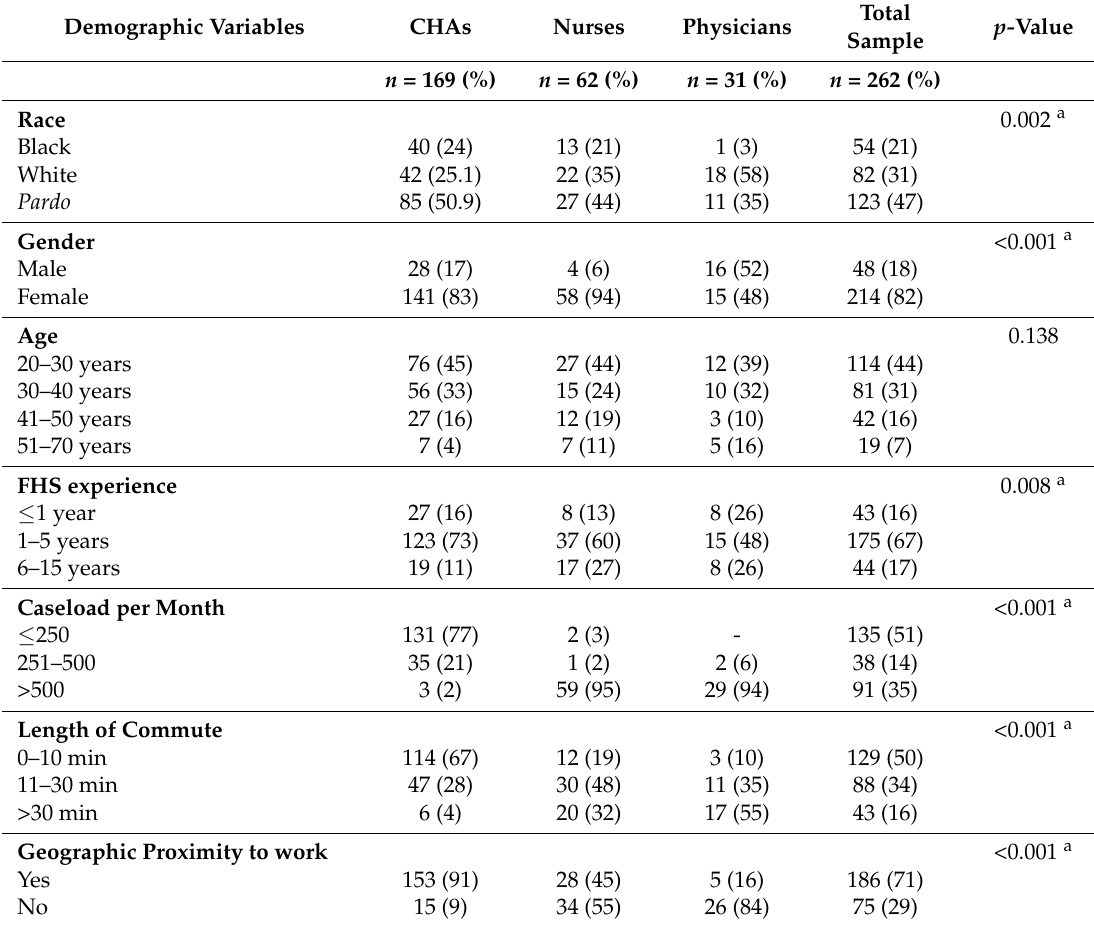
Table 2. Demographics and Job Context (Practitioner